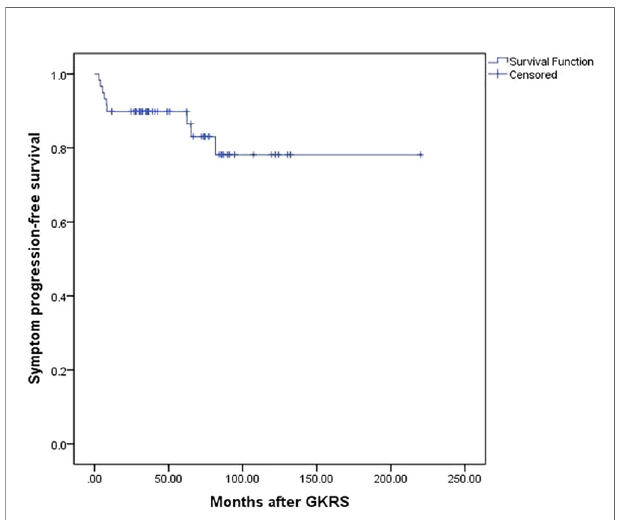
FIGURE 2 | Kaplan-Meier curve of progression-free Survival for the entire series.